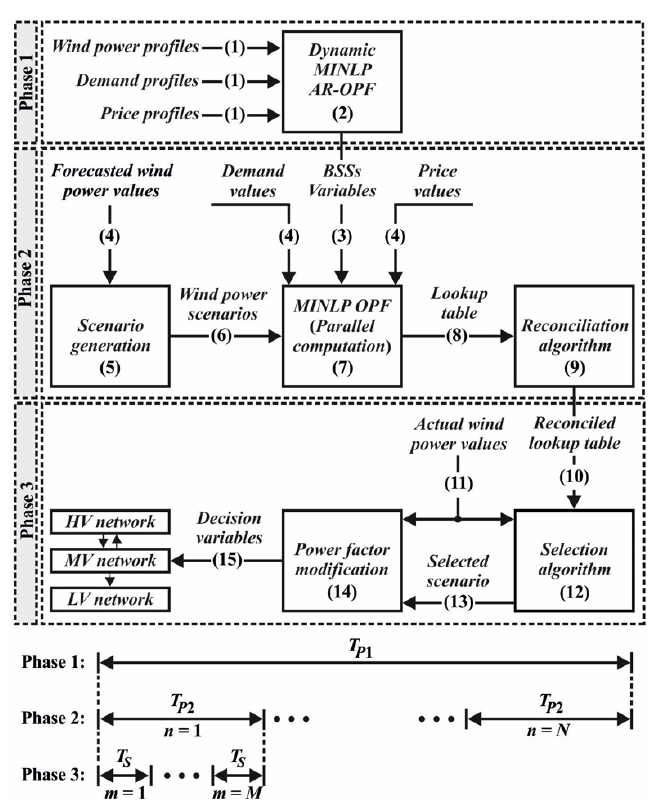
Figure 1. The proposed framework for RT ‐ DAR ‐ OPF.